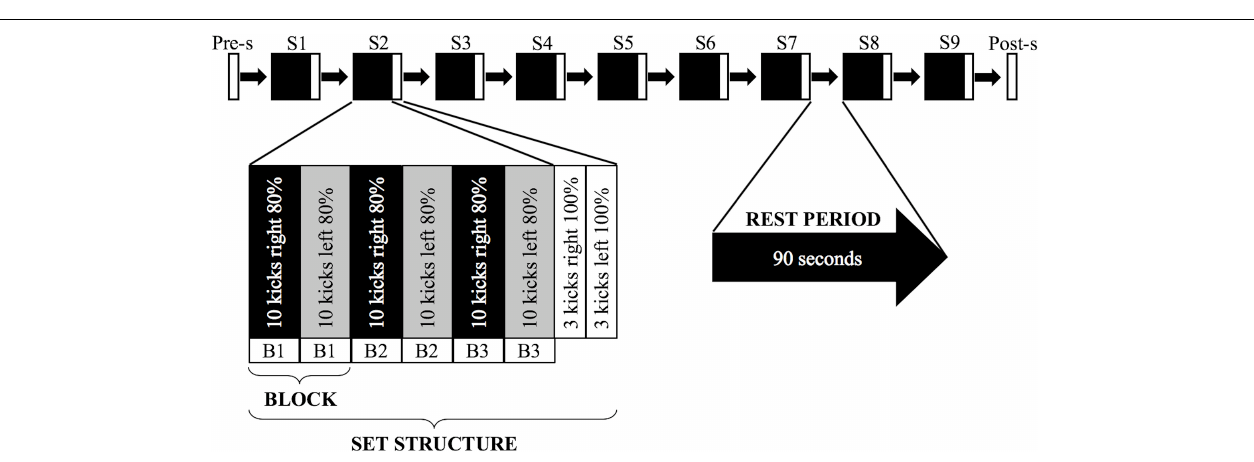
reported by the participants before the warm-up phase